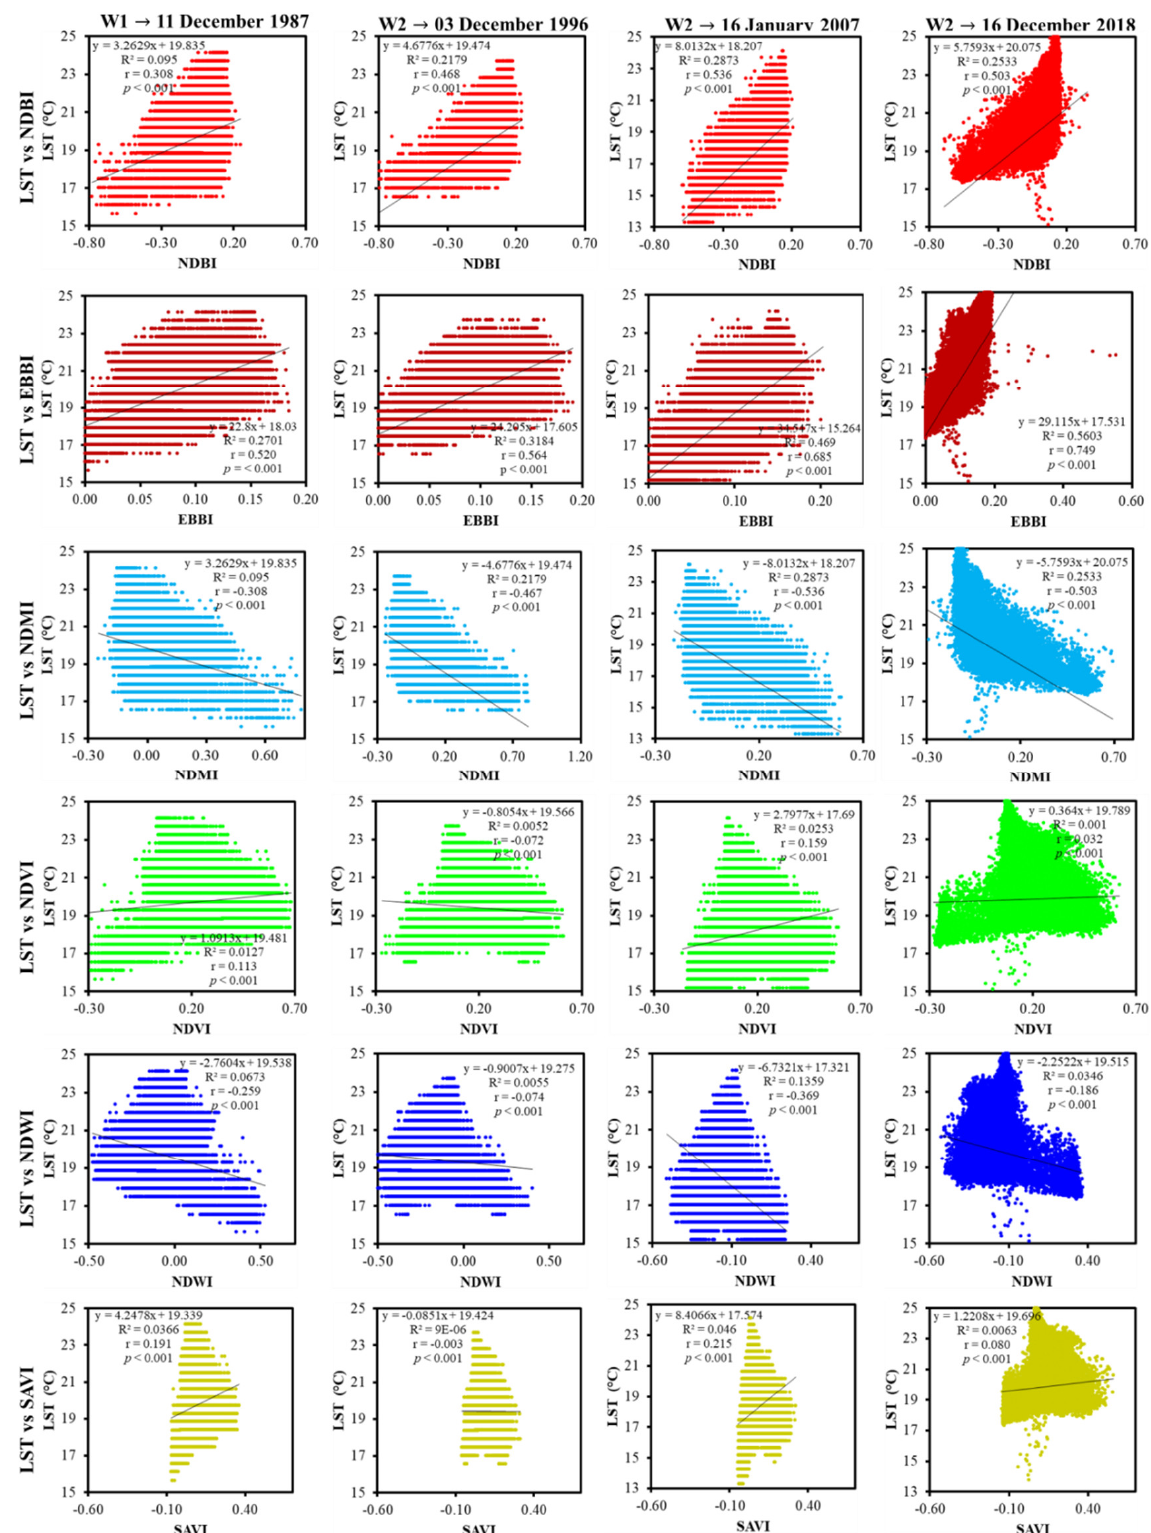
Figure 14. Correlation between the LST and the six land indices of Prayagraj city in the winter season (1987–2018).